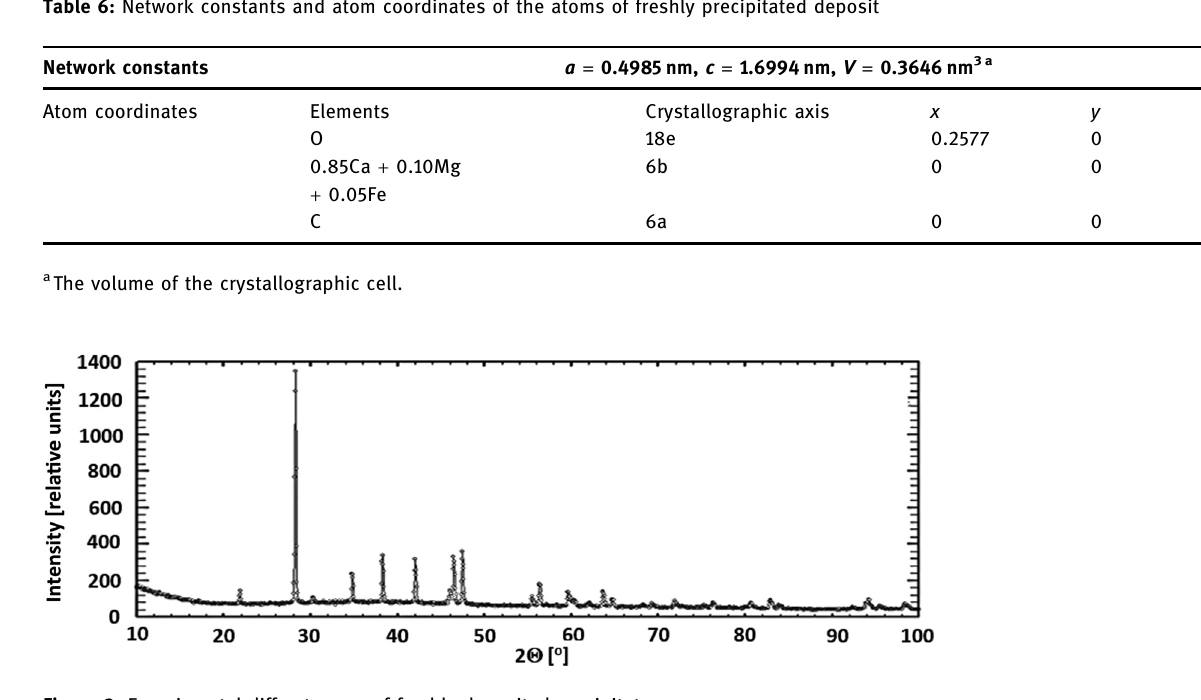
Figure 3: Experimental di ff ractogram of freshly deposited precipitate.